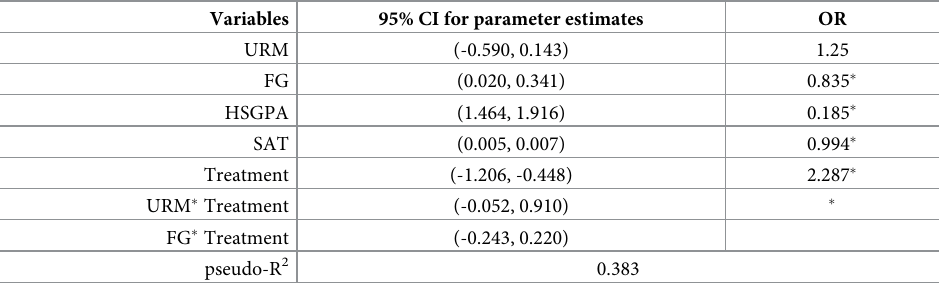
Table 1. Ordinal regression model for final grade in Principles of Biology I with point estimates, standard errors, and odds ratios (N = 2877, df =